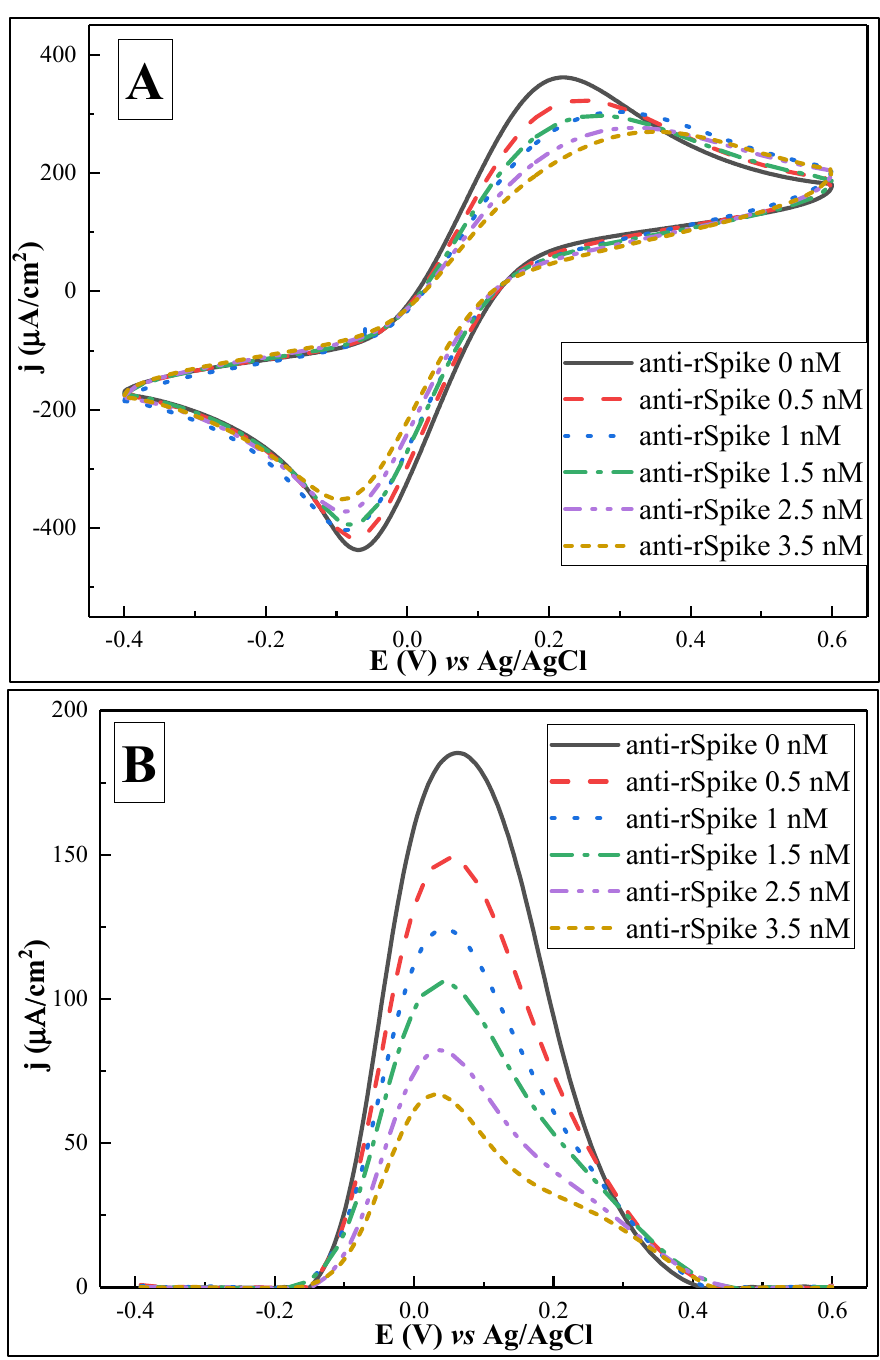
Figure 8. Cyclic voltammograms ( A ) and differential pulse voltammograms ( B ) after interaction with anti-rSpike antibodies of different concentrations (0–3.5 nM). Potential range was from − 0.4 to +0.6 V, with a CV scan rate of 0.05 V/s, DPV step size of 0.004 V, pulse height of 0.05 V, pulse period of 100 ms, and pulse width of 50 ms, in 10 mM PBS, pH 7.4, containing 2 mM [Fe(CN 6 )] 3 − /4 − . Signal normalised to the geometrical area of the working electrode (0.126 cm 2 ). Data are represented as means of three independent experiments.